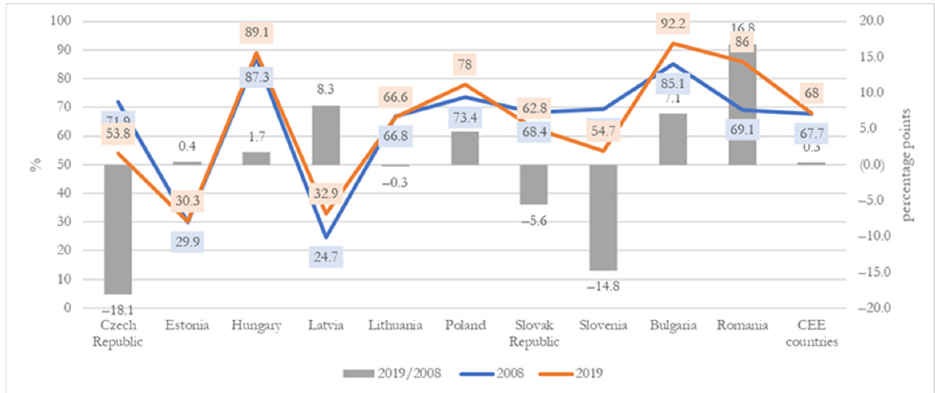
Figure 5. Share of exports biomass for food and feed in exports of biomass (%) (based on OECD.Stat data [36], retrieved on 15 February 2022).